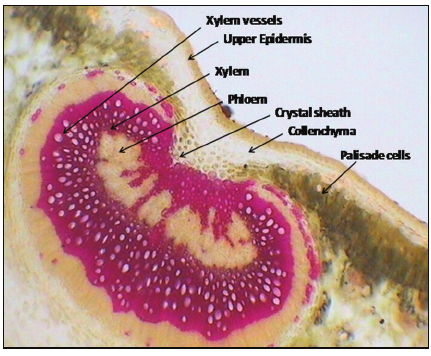
Figure 3: T.S. of leaf showing midrib and lamina (40x).